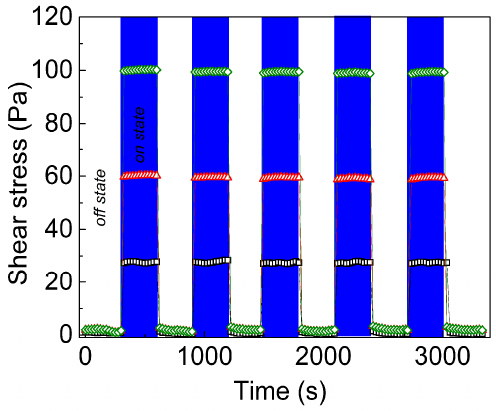
Figure 8. On/off cycles, showing the change of the shear stress for unmodified GO ( ), GO- PHEMATMS − 1 ( ), and GO-PHEMATMS-2 ( ) silicone oil suspensions during time in the absence and in the presence of an external electric field of 1.5 kV mm − 1 .